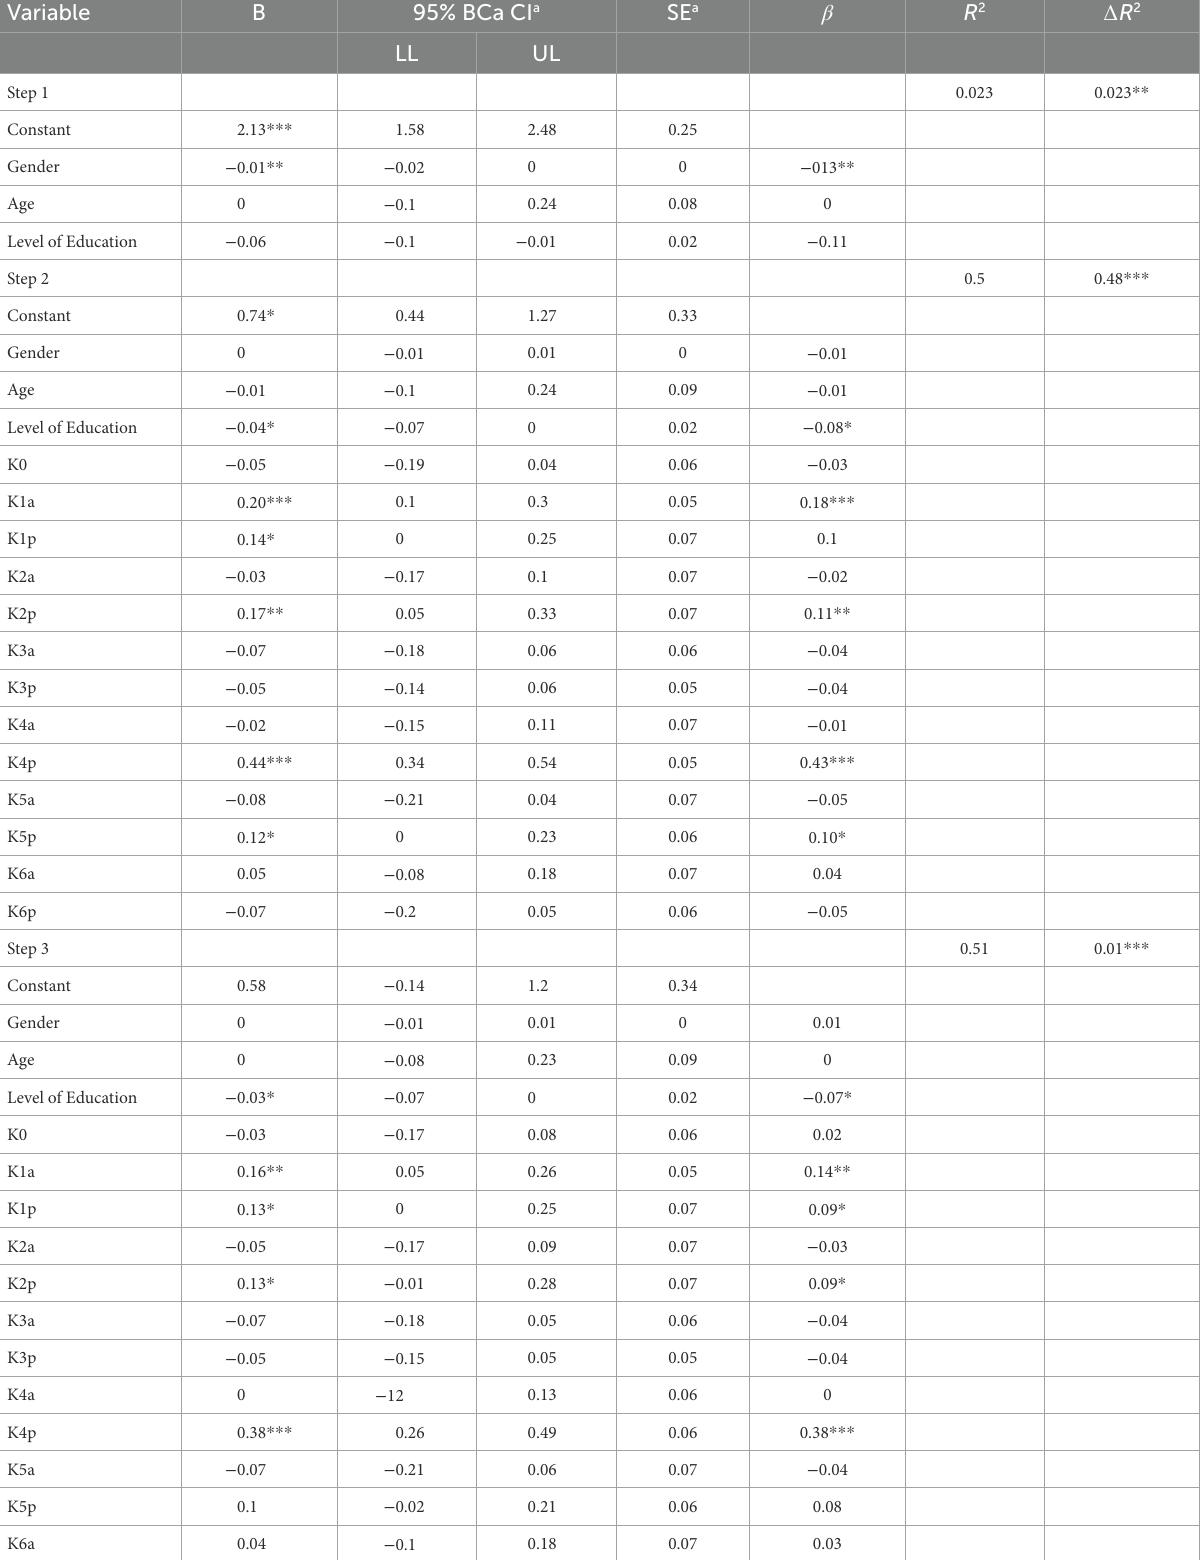
TABLE 5 Hierarchical regression results for burnout